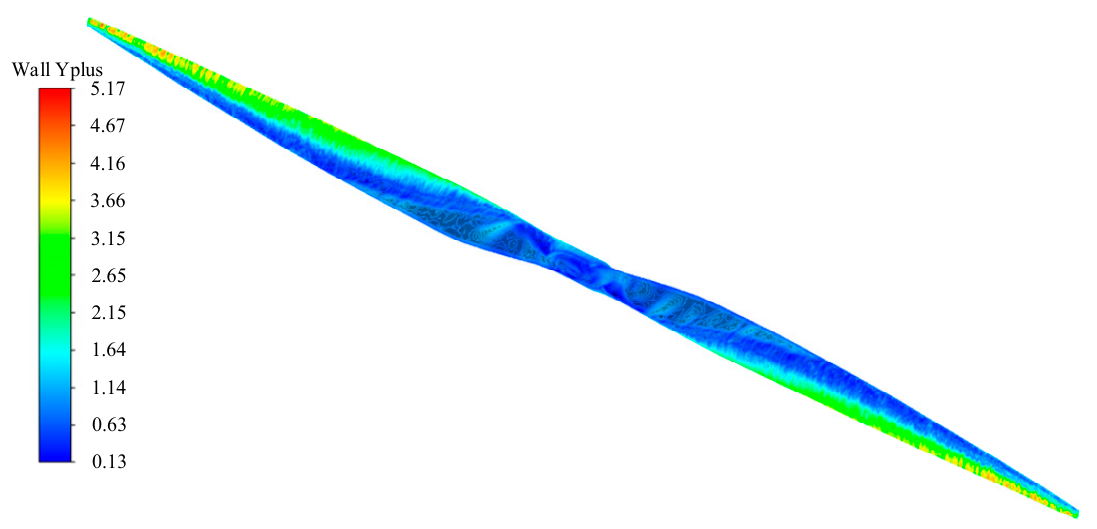
Figure 10. Blade y+